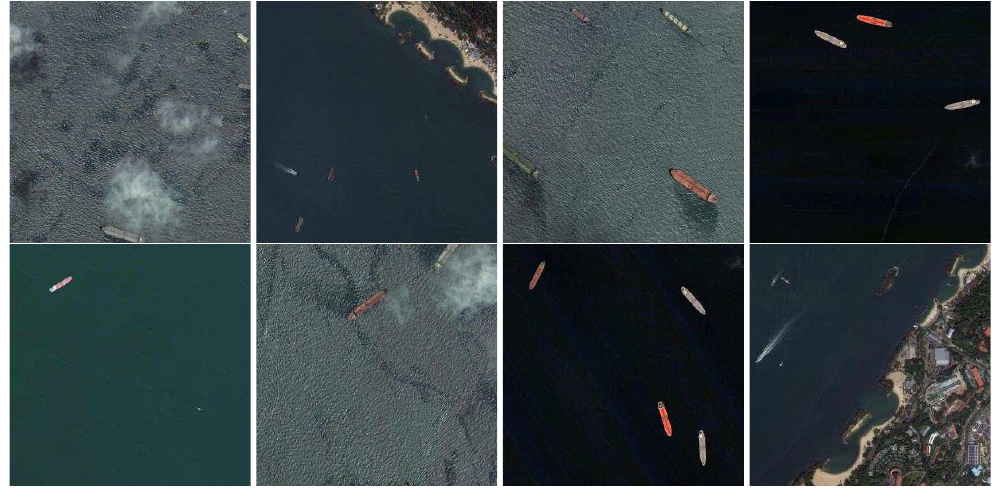
Figure 2. Sample images in the training set.